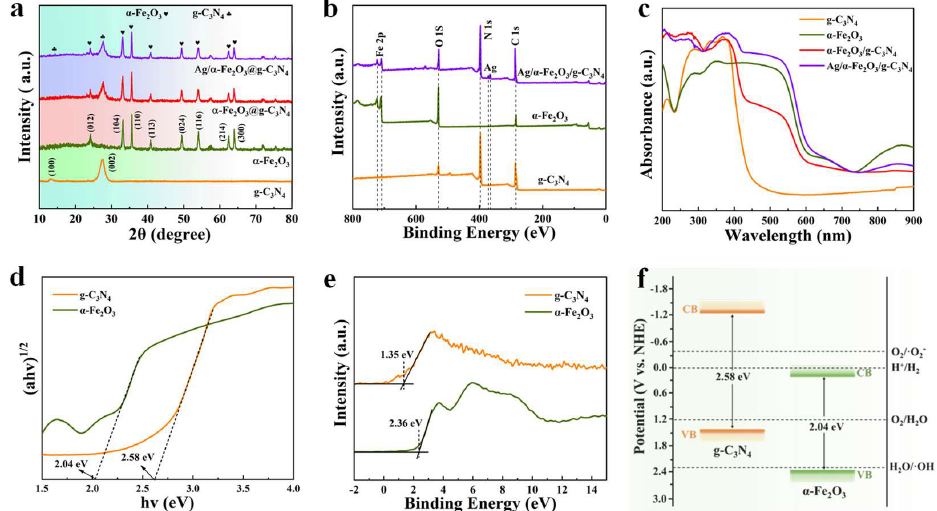
Figure 2. XRD patterns ( a ), XPS full spectra ( b ) and UV-vis DRS spectra ( c ) of g-C 3 N 4 , α-Fe 2 O 3 and Ag/α-Fe 2 O 3 /g-C 3 N 4 , band gap ( d ), VB-XPS I and relative energy band position maps ( f ) of g-C 3 N 4 and α-Fe 2 O 3